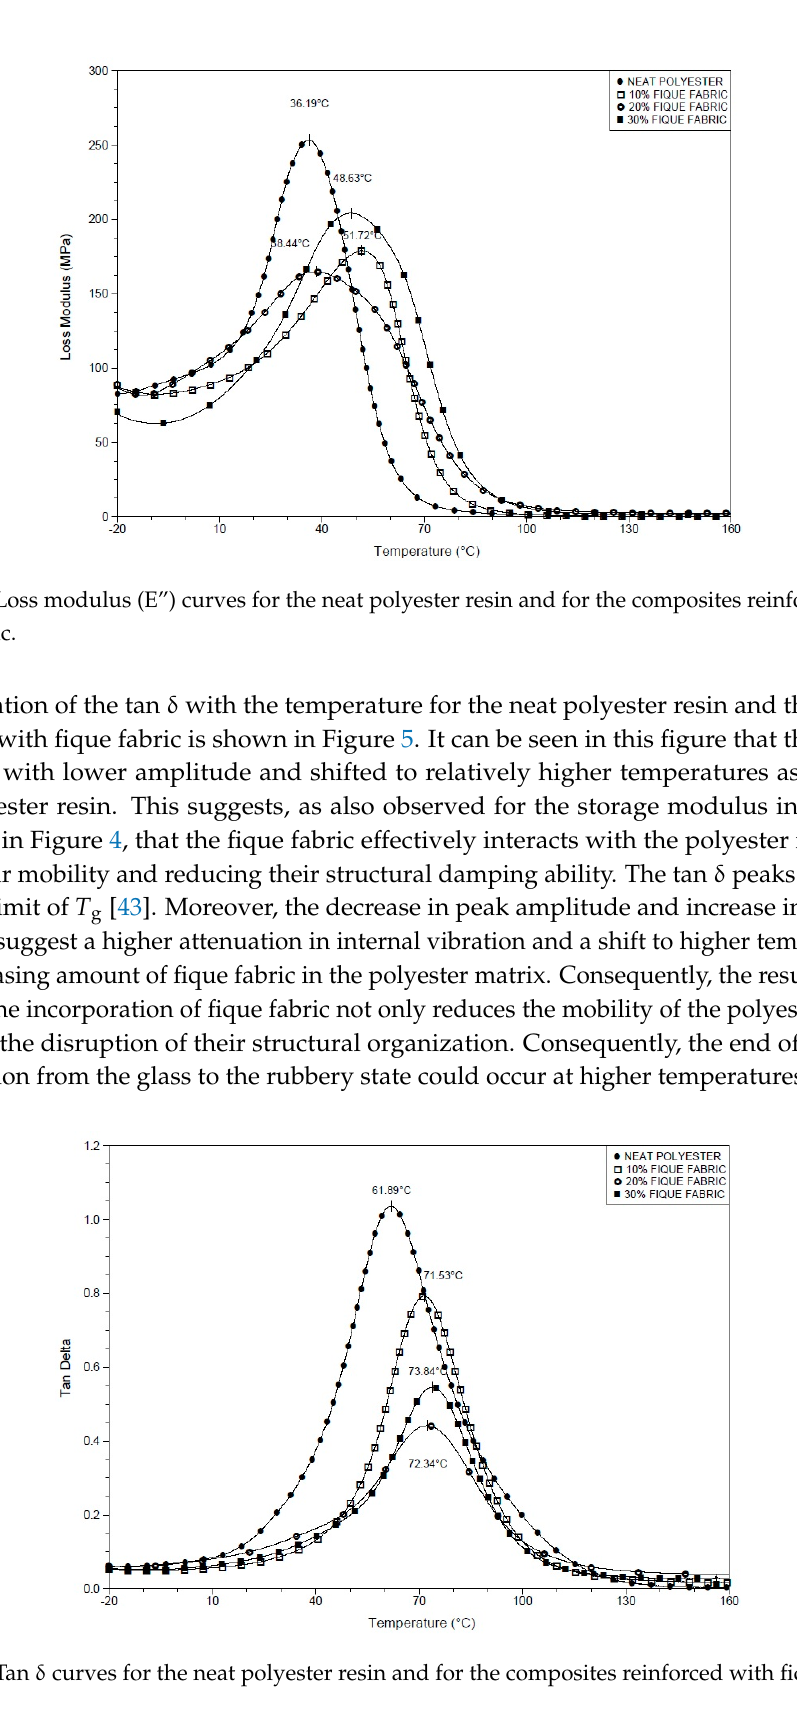
Figure 5. Tan δ curves for the neat polyester resin and for the composites reinforced with fique fabric.